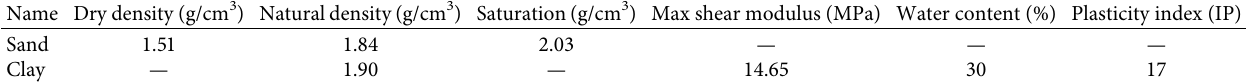
Table 3: Soil layer parameters.